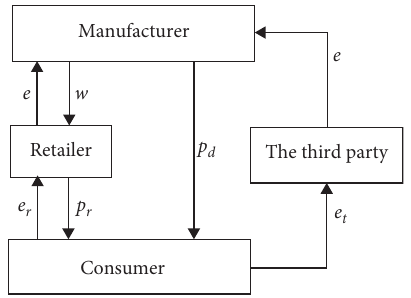
Figure 1: The structure of the whole supply chain